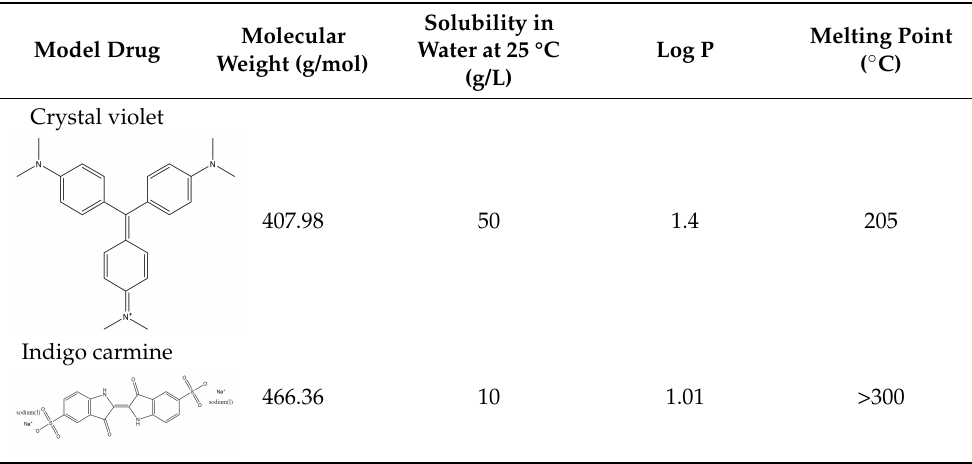
Table 3. Physicochemical properties of selected model drugs